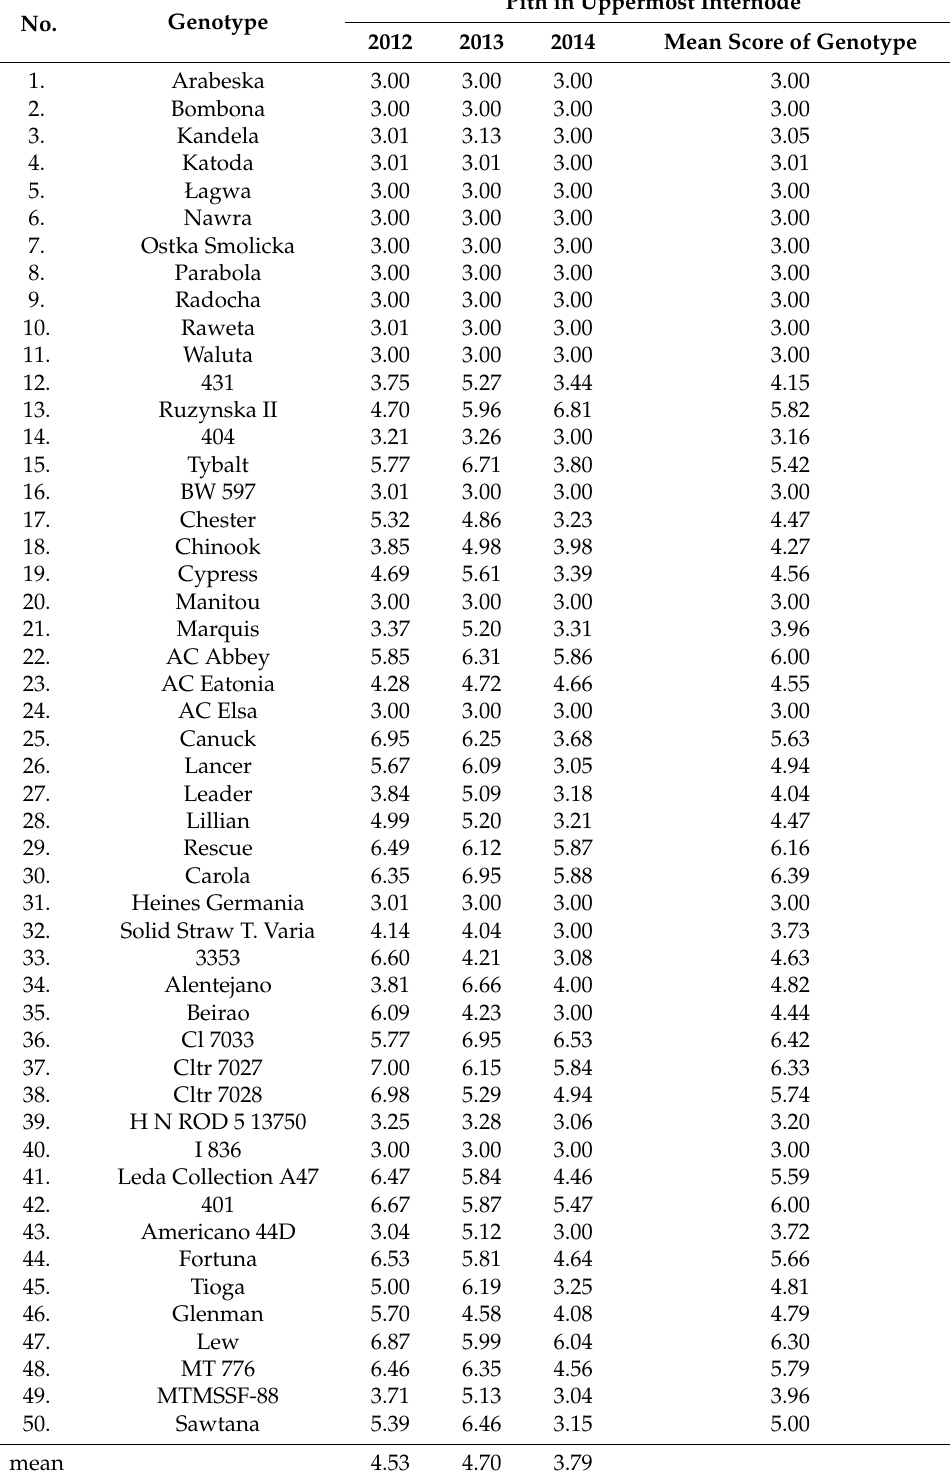
Table 1. The average filling of the uppermost internode of the stem with pith in 50 spring wheat geno- types (Agricultural Research Station Dło´n, 2012–2014) according to the methodology recommended by the